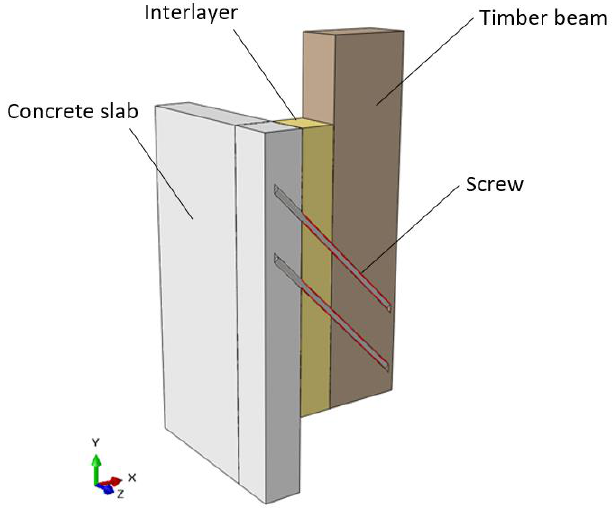
Figure 3. Example of a typical FE assembly of TCC connection (1/4th of the experimental geometry, with hidden mesh).